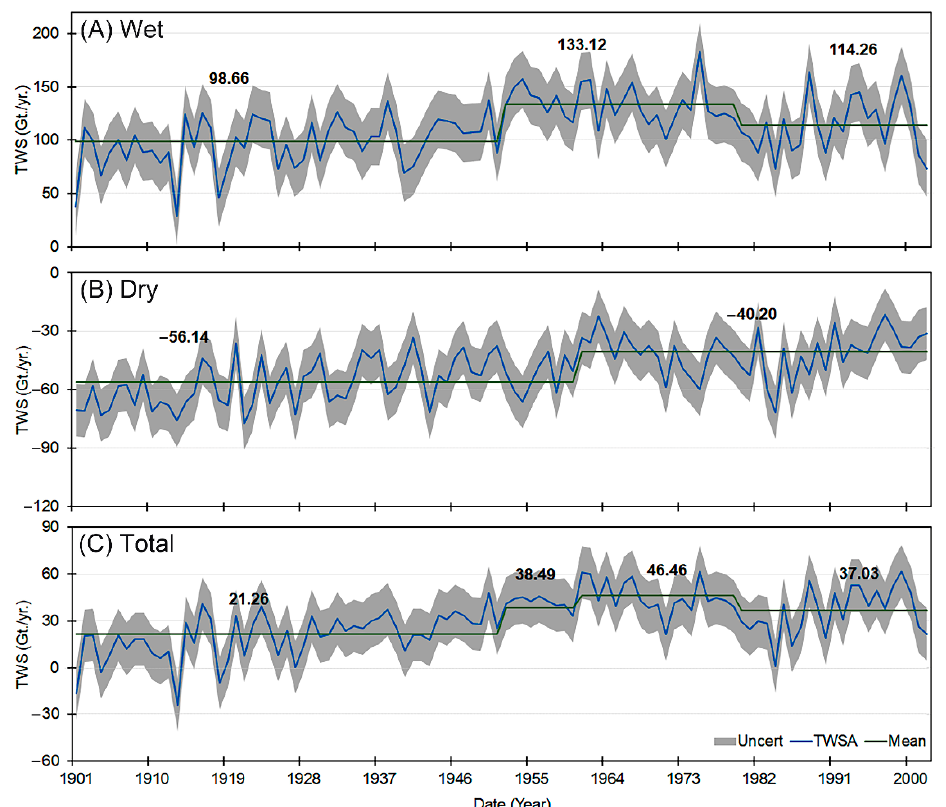
Figure 9. Reconstructed TWS in the NRB between 1901 to 2002 during the wet ( A ), dry period ( B ), and plot ( C ) shows the total water storage during the two seasons.